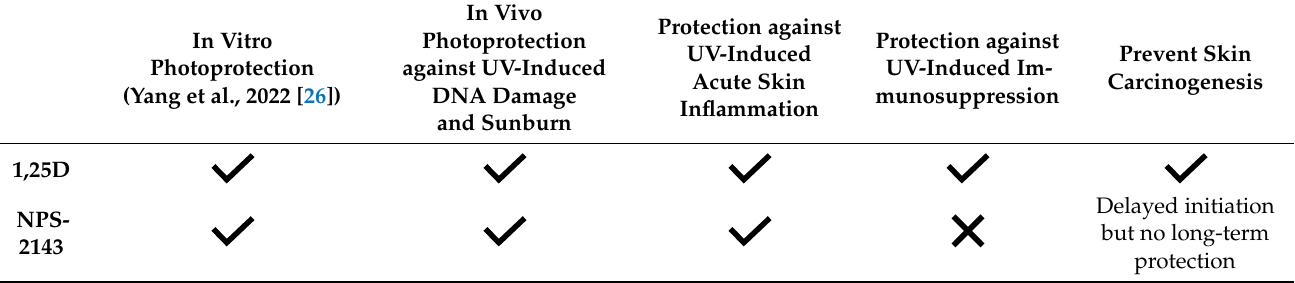
Table 2. A schematic representation of the differences between the effects of 1,25D and NPS-2143. In Vitro